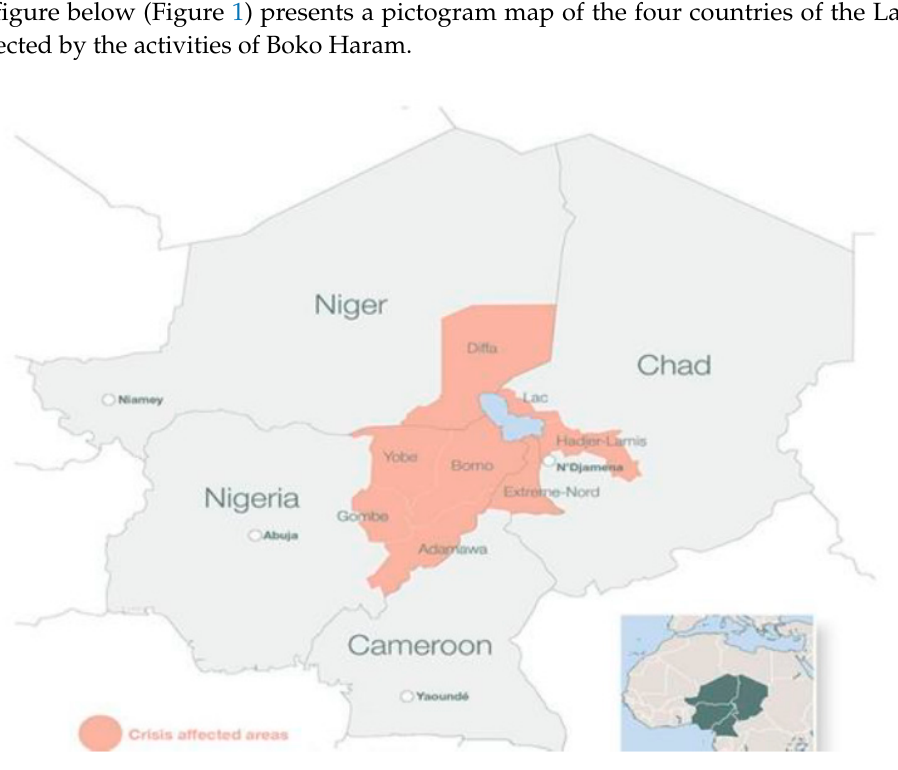
Figure 1. The a ff ected countries of the Lake Chad region. Source: Smith 2016. “The Lake Chad crisis explained”.